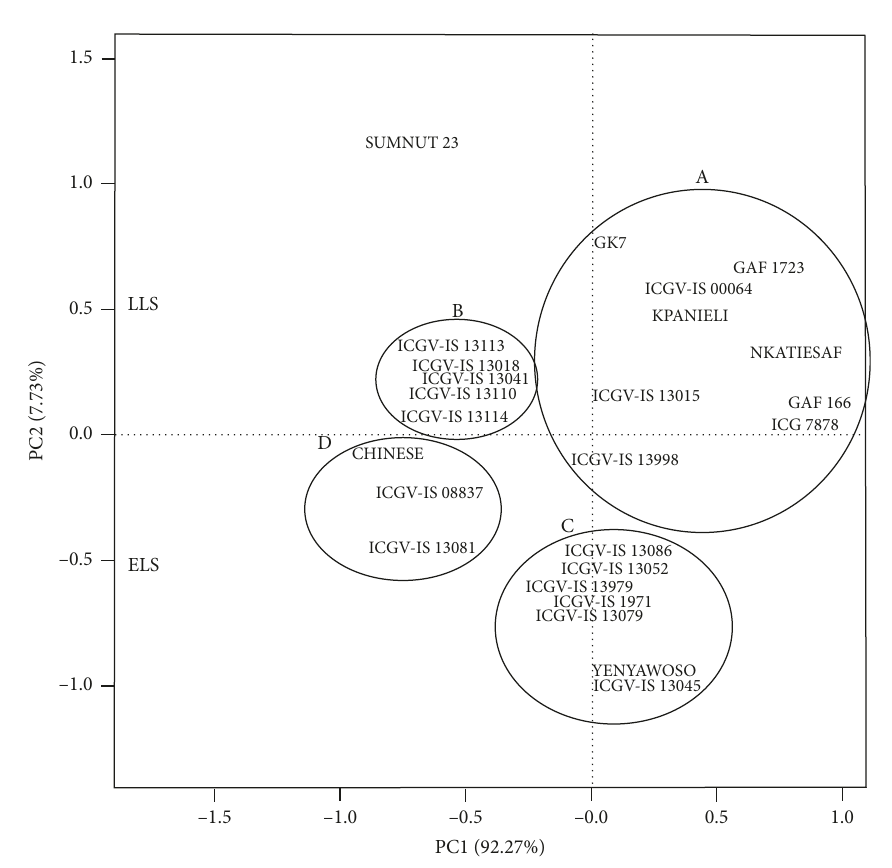
Figure 1: A plot of principal component analysis using the AUDPCs of ELS and LLS. “A,” “B and C,” and “D” denote stay-green, moderately stay-green, and non-stay-green clusters, respectively. Table 7: Comparison of different stay-green classes for pod yield, LAUG, ELS AUDPC, and LLS AUDPC. Stay-Green Classes No. of genotypes Stay-green (SG) Means followed by different letters are significantly different at 0.05 probability level. LAUG: leaf area under greenness; AUDPC: area under disease progress curve; ELS: early leaf spot; LLS: late leaf